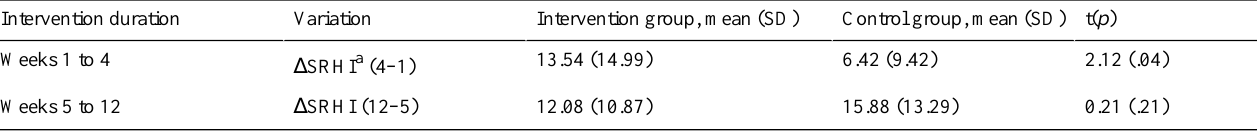
Table 4. Self-Report Habit Index variation based on the difference of